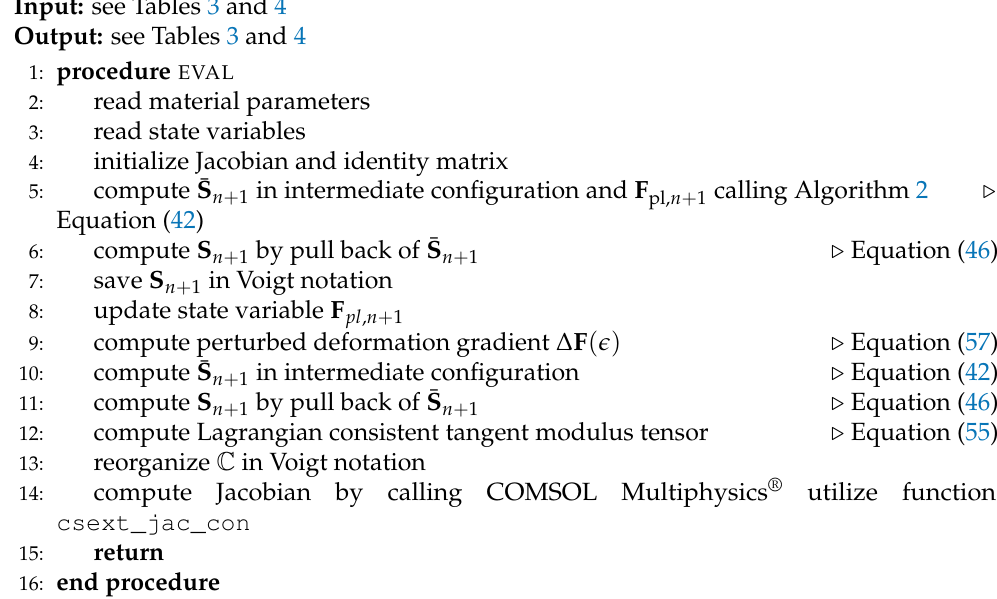
Algorithm 1 Main routine implemented in COMSOL Multiphysics ® for the calculation of S and J